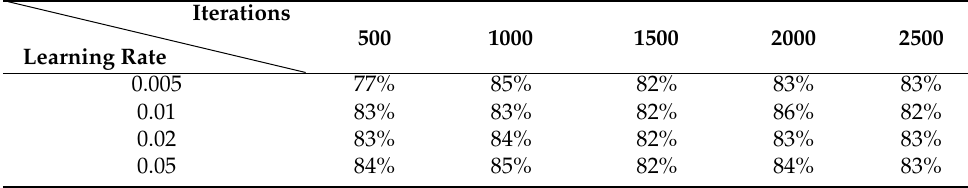
Table 3. Training recognition rate of the model using different parameters.